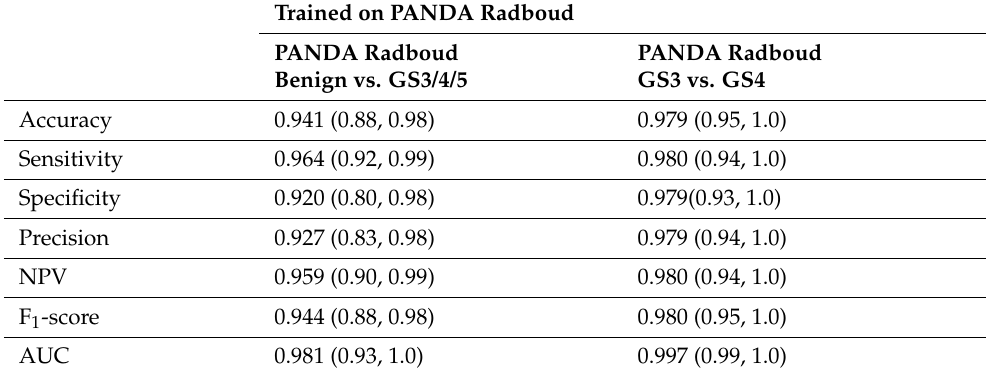
Table 3. PANDA Radboud classifier scores.